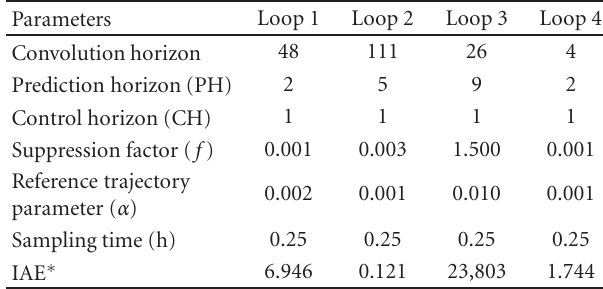
Table 3: Parameters of the DMC to the regulatory problem.